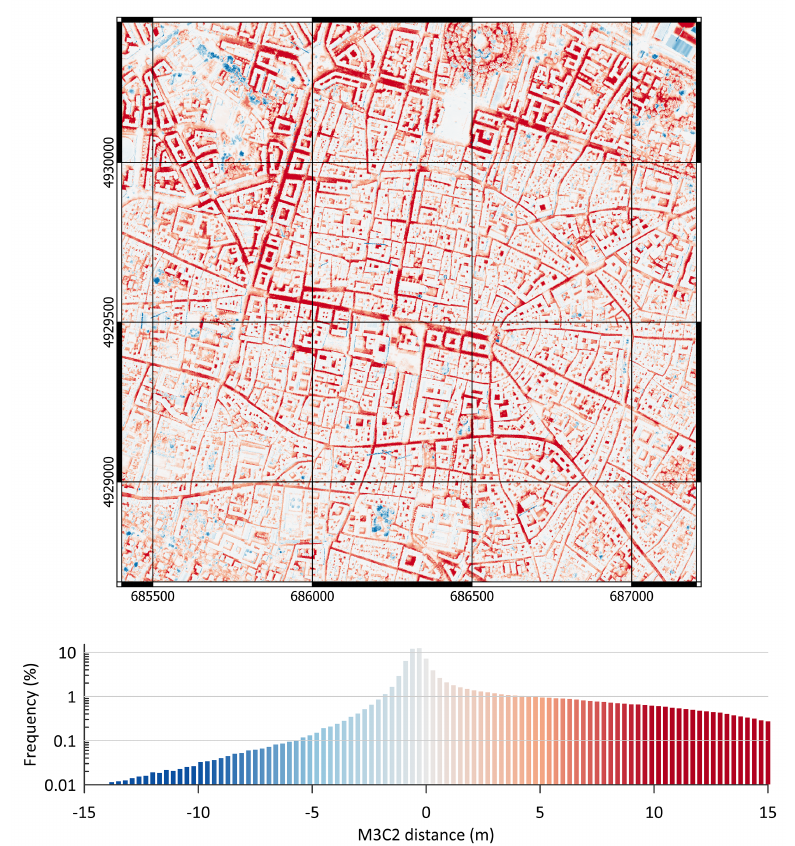
Figure 7. Map and histogram of the M3C2 distance between the Average DEM and the reference LiDAR data in the Centre